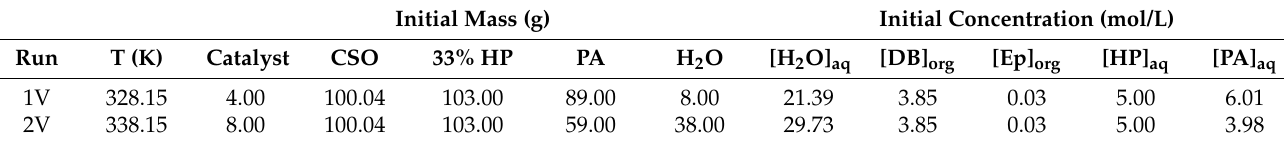
Table 2. Experimental matrix for the validation of epoxidation of cottonseed oil model. (DB: double bond, EP: epoxide, PA: propionic acid, and HP: hydrogen peroxide). Initial Mass